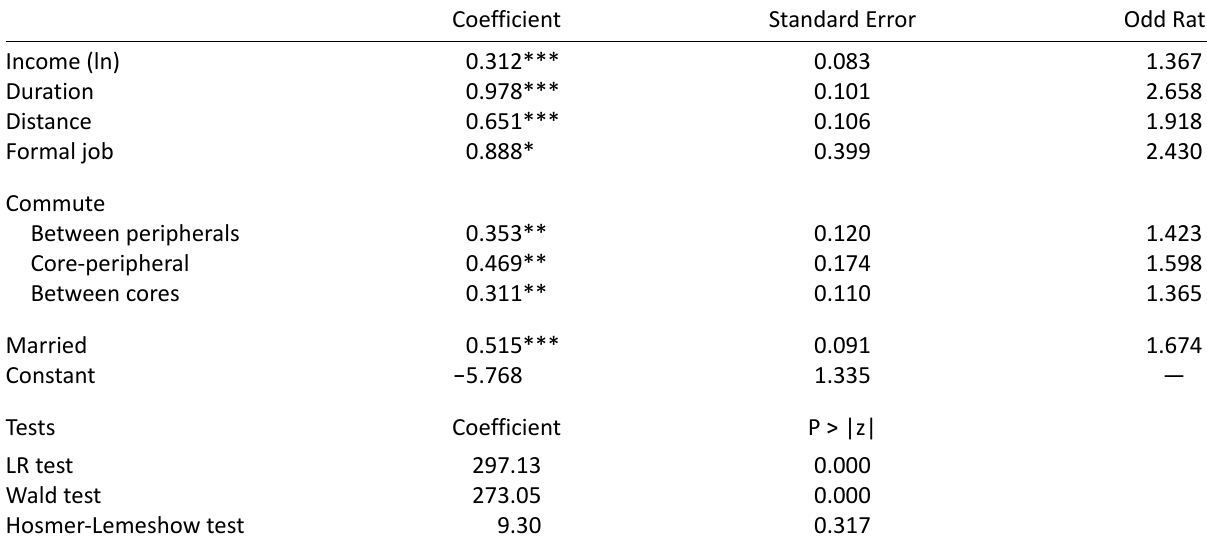
Table 7. Odds ratio of logistic regression of transportation mode choices.